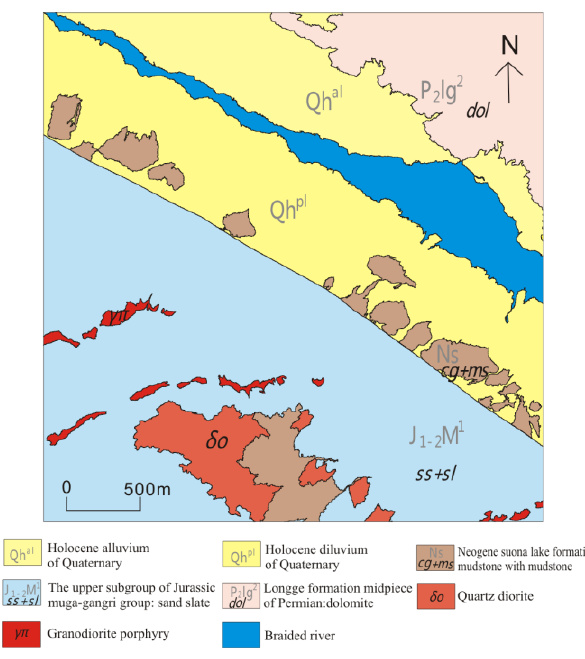
Figure 1 Simplified geological map of research area